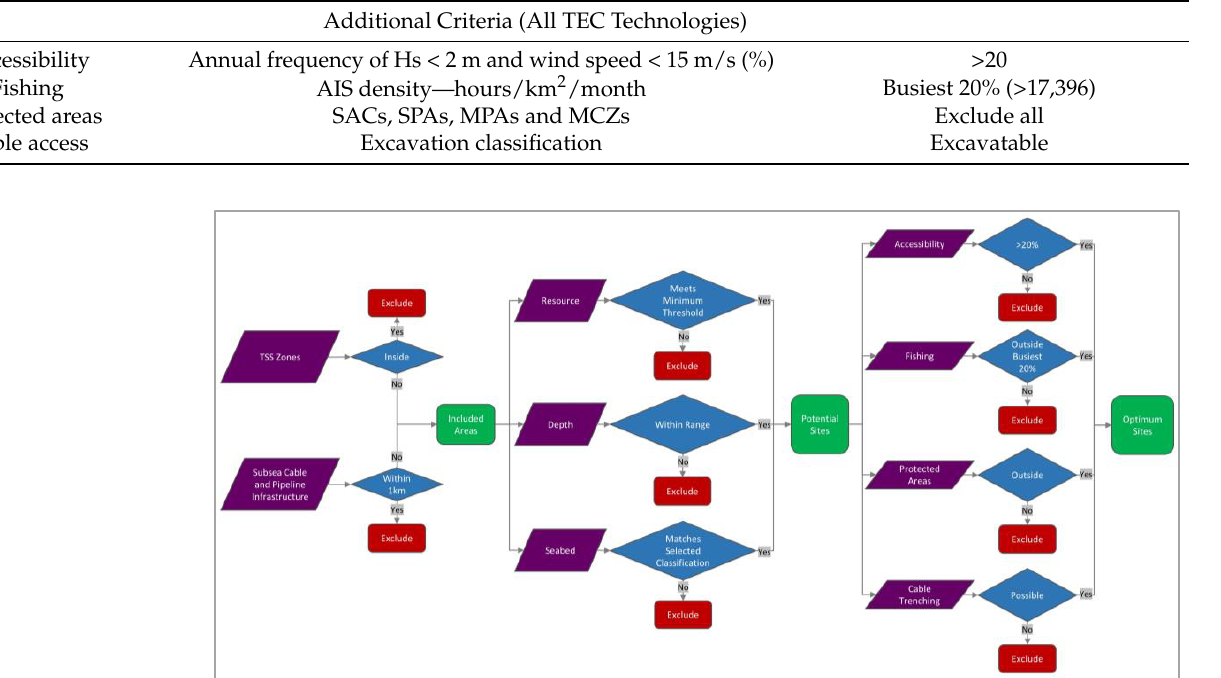
Figure 7. The workflow for identifying potential and optimum sites in the case study.